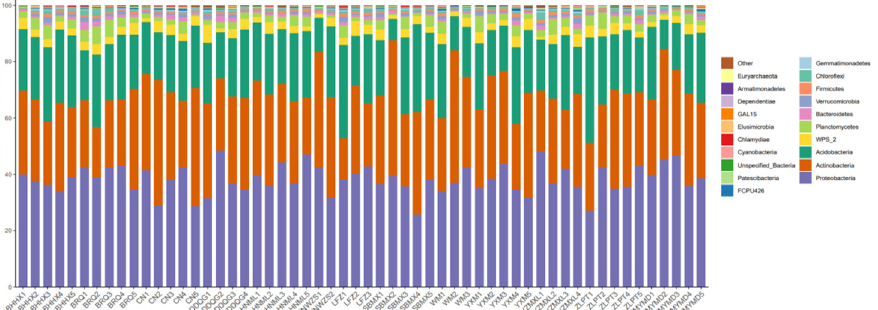
Figure 2. Relative abundance of the first 20 phylum levels of bacterial communities in the samples.